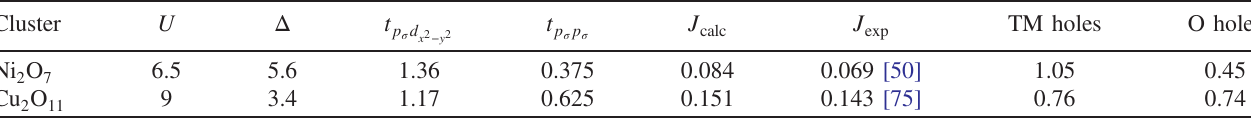
TABLE I. Representative parameters used for the ED calculations. Full details are provided in Appendix C. Note that U is the on-site intraorbital Coulomb interaction for the 3 d orbitals, and Δ measures the charge-transfer energy. These parameters have an estimated error bar of about 1 eV [65]. Here, t is the hopping integral between planar p σ and d orbitals while t is that among the p σ p σ d p σ p σ x 2 − y 2 x 2 − y 2 orbitals. The column labeled J is the singlet-triplet energy splitting of the undoped ( d 9 ) cluster (two holes in total), and J is the calc exp superexchange interaction from experiment. These parameters are given in eV. The column labeled TM holes is the hole occupation of the TM orbitals per TM site of the doped 2-TM site clusters (which have three holes in total). The column labeled O holes is the hole occupation of the oxygen orbitals per TM